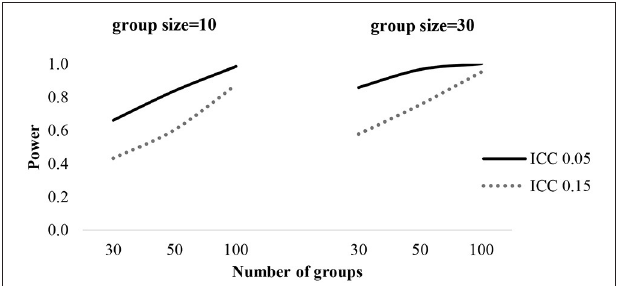
FIGURE 4 | Statistical power of Z coefficients ( γ 001